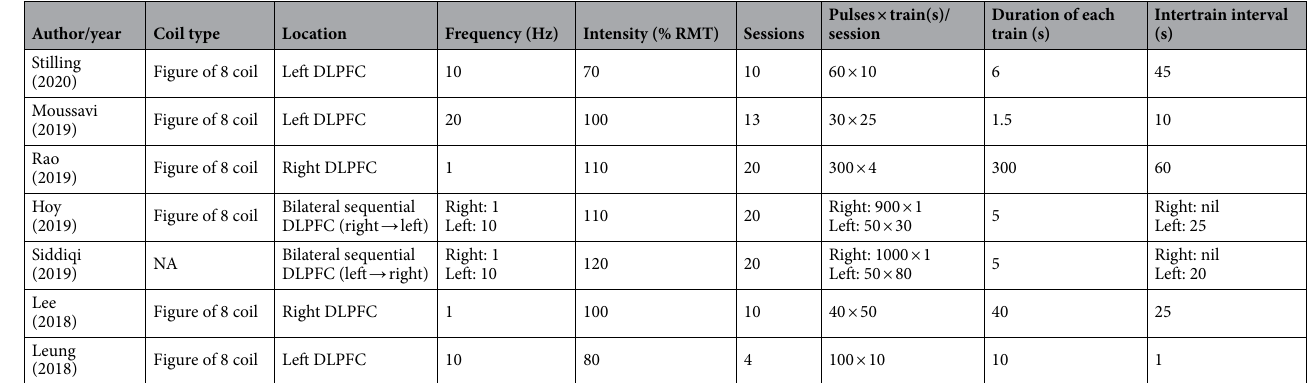
Table 2. Summary of rTMS protocols in included studies. DLPFC dorsolateral prefrontal cortex, RMT resting motor threshold.